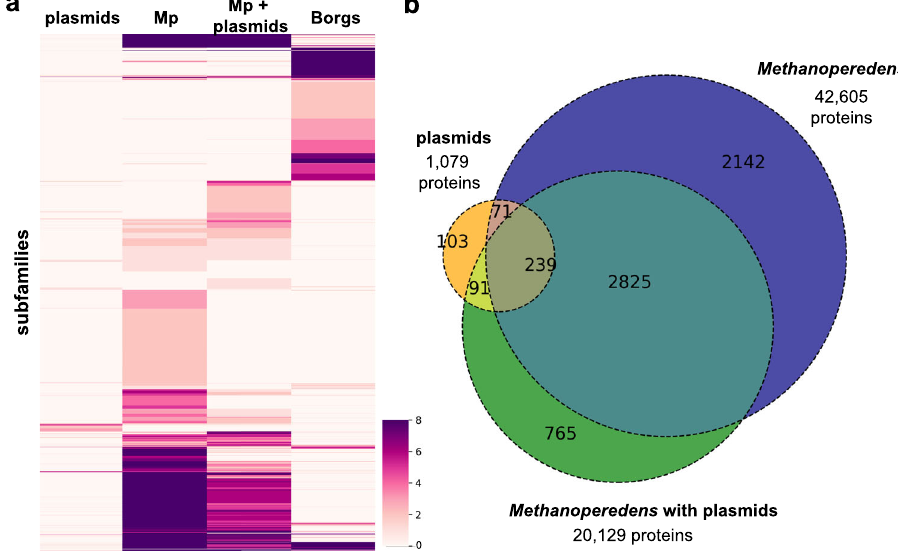
Fig.5|Proteinclusteringanalysesanddistributionofproteinsubfamiliesacrossmainelements.a Heatmapshowingproteinsubfamilies(subfamilies ≥ 8areallshown in dark purple). b Subfamily distribution across plasmids, Methanoperedens with plasmids and Methanoperedens without